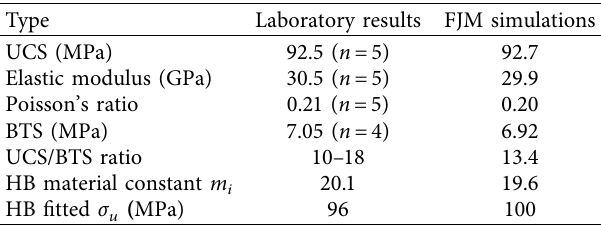
Table 3: Results of the laboratory tests and FJM simulations.